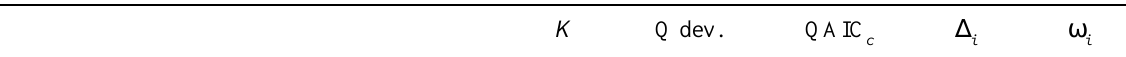
Table 2. Sets of competing best multi-strata mark-recapture models for 14 species of songbirds breeding in boreal forests of western Newfoundland, 2003-2006. Best models are highlighted in bold. The last model reported in each set is the most general global model, which was used to calculate the variance inflation factor for that model set (c-hat). Effective n is the number of releases of marked individuals back into the population up to the penultimate net round, whereas % CUT indicates the percentage of captures that occurred on netting sites located in clearcut landscapes, i.e., vs. naturally fragmented landscapes. Species codes are from Table 1. † Terms in models are as follows: land = landscape type (CUT or NAT); sex = sex; tp4 = 4 time phases for S (breeding season newly-marked, breeding season resident, over winter newly- marked, and over winter resident); tp3 = as with tp4, but with residents and newly marked birds combined to estimate only one over winter survival rate; year = year; trend = linear trend in p within each breeding season; round = independent estimation of p for each net round within a season; effort = net effort; time = independent estimate of p for every net round in every year; t2 = Y for two periods, i.e., breeding season and over